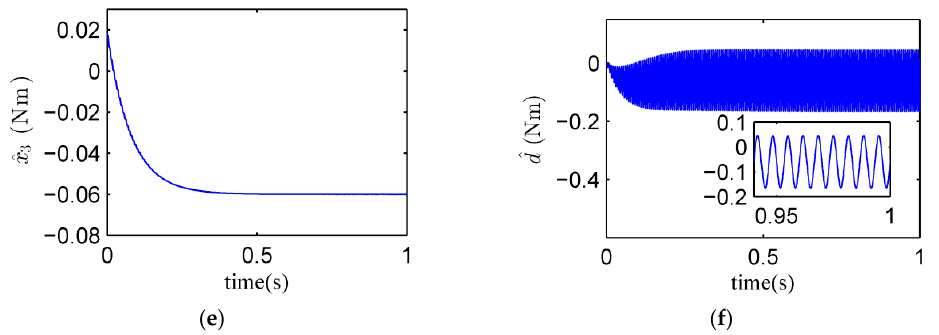
Figure 10. Experimental curves when  = 9000 r/min. ( a ) gimbal speed ω ; ( b ) electromagnetic Figure 10. Experimental curves when Ω = 9000 r/min. ( a ) gimbal speed ω ; ( b ) electromagnetic torque torque T e ; ( c ) estimate of T dz ; ( d ) estimate of u d ; ( e ) estimate of x 3 ; ( f ) estimate of d . T e ; ( c ) estimate of T dz ; ( d ) estimate of u d ; ( e ) estimate of x 3 ; ( f ) estimate of d . Table 2. Estimates of rotor dynamic imbalance u d . Table 2. Estimates of rotor dynamic imbalance u d